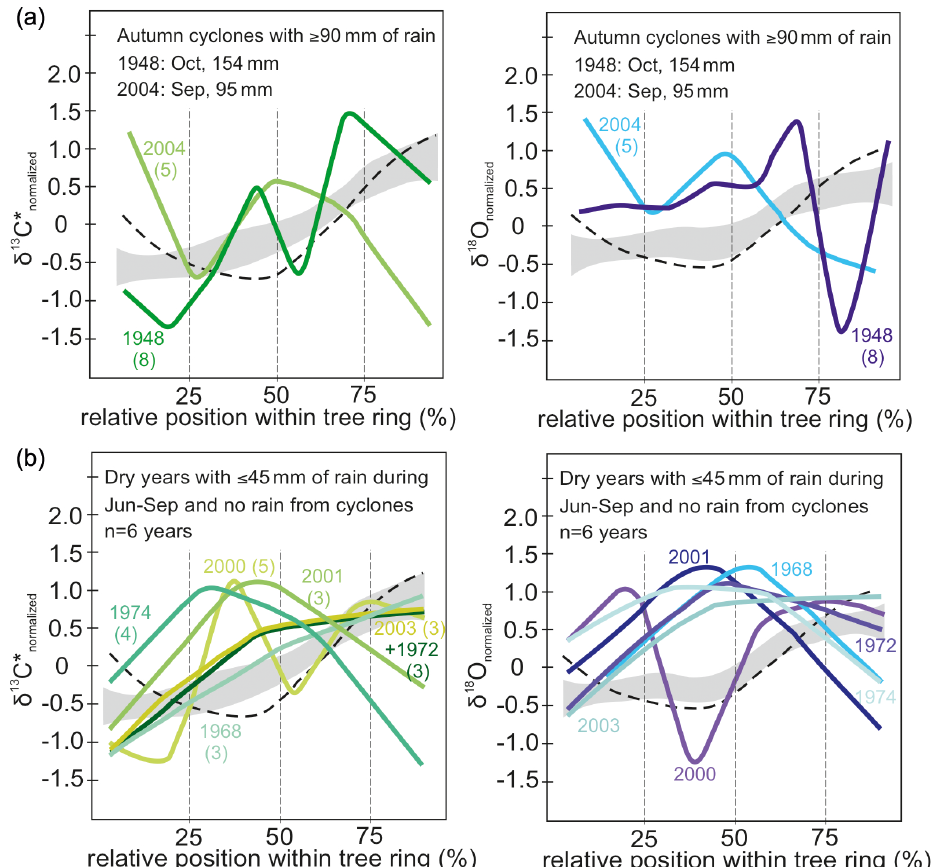
Figure 6. (a) Intra-annual course of normalized δ 13 C ∗ (green) and δ 18 O (blue) values for years with autumn cyclones bringing ≥ 90mm of rain ( n = 2) and (b) dry years with ≥ 45mm monsoonal precipitation and no rain from cyclones ( n = 6). Numbers in brackets indicate number of isotope samples analyzed per year. Grey shaded area marks the intra-annual course of isotope ratios with standard error for all years with more than three observations. The dashed line indicates intra-annual course of isotopes for years with spring cyclones, illustrated in detail in Fig. 5c. Rain from autumn cyclones may affect the intra-annual isotope signature by more strongly declining values towards the end of a tree ring. Years with 45mm of monsoon precipitation or less show an increase in δ 13 C ∗ towards the middle of each tree ring and then decline or increase only slightly towards the end. Rather similar seasonal trends can be observed for δ 18 O values. Hence, dry monsoon seasons usually cause higher isotope values in the middle part of each tree ring than during normal years. Please see text for further details on the conspicuous seasonal trends in 1948 and